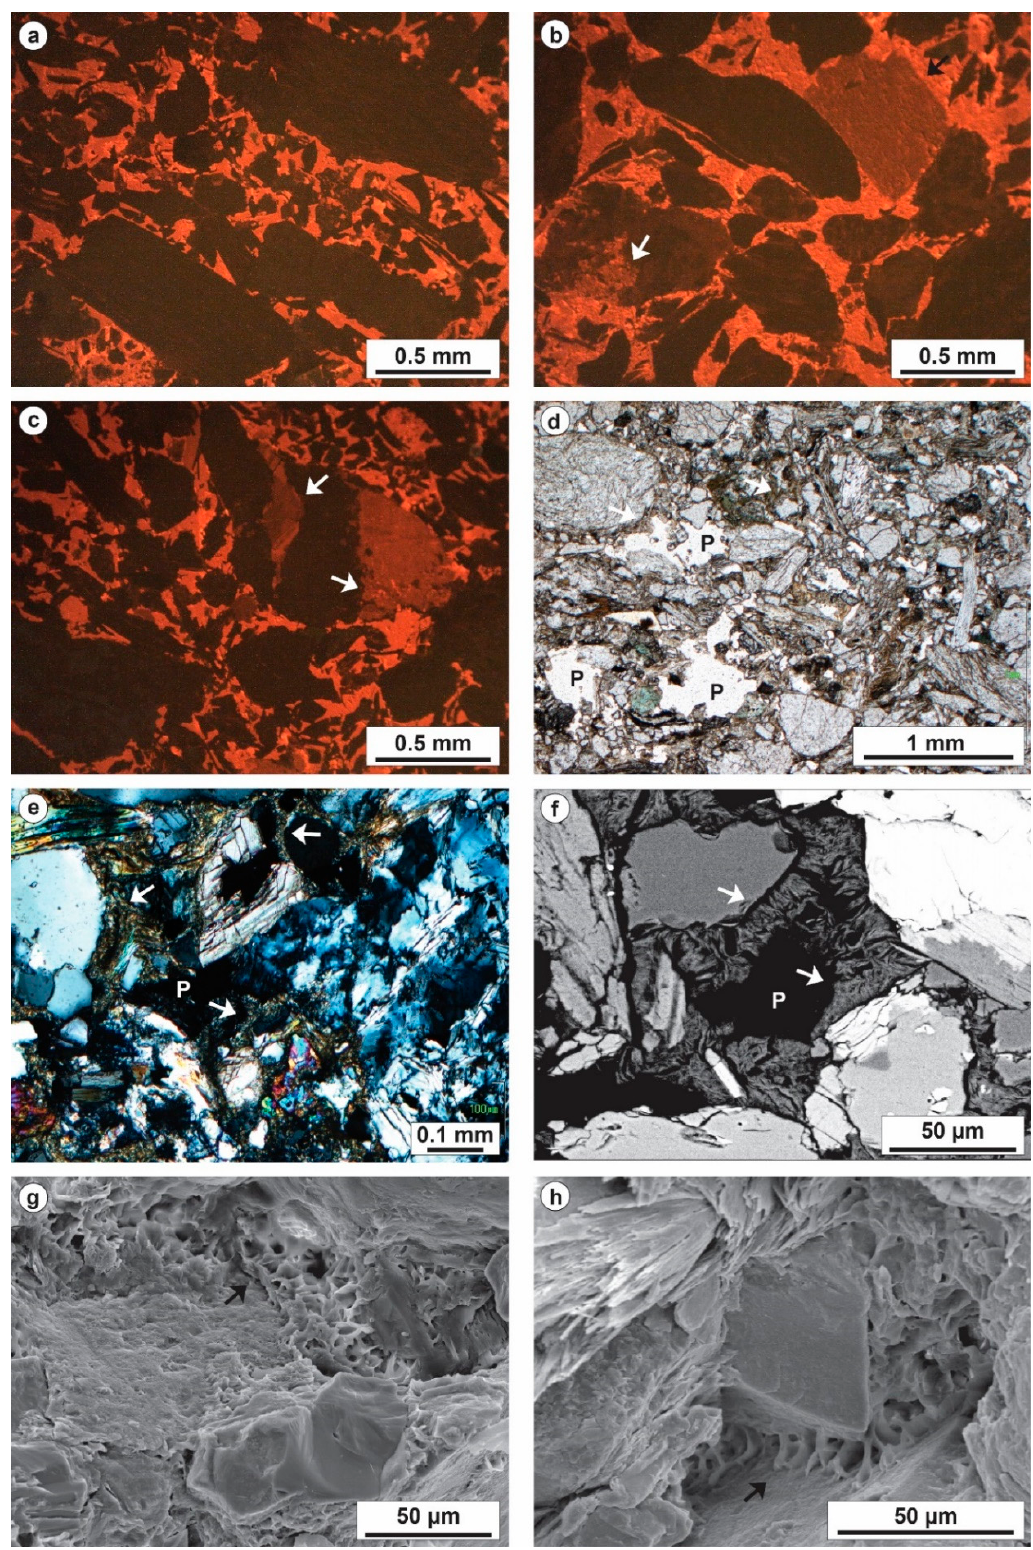
Figure 12. ( a ) Cathodoluminescence (CL) photomicrograph showing that the poikilotopic calcite cement is uniformly bright orange luminescent and it follows mechanical compaction; ( b ) CL image showing bright luminescent poikilotopic calcite cement, dull detrital crystalline carbonate grain (black arrow) and dull calcite partially replacing a detrital grain (white arrow). Grain contacts are